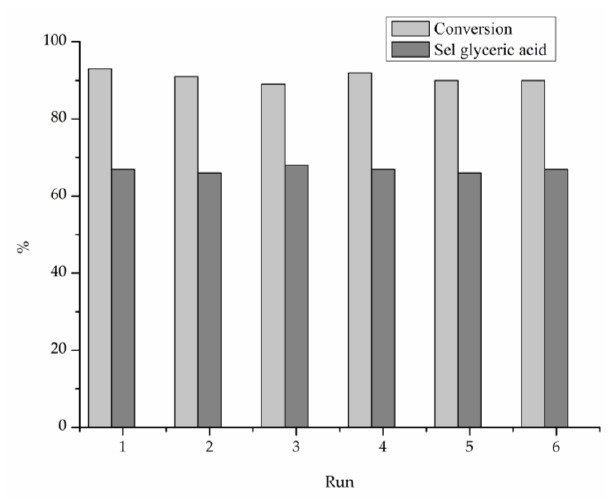
Figure 4. Stability test for Au 9 Pt 1 /AC in the glycerol oxidation in presence of NaOH, reaction time 0.5 h. Table 2. Catalytic evaluation in the glycerol oxidation in presence of NaOH 1 .